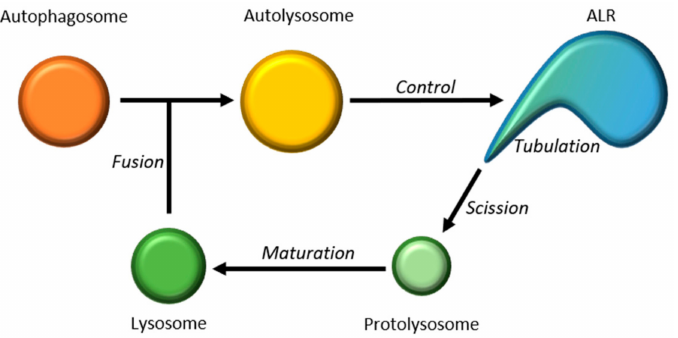
Figure 2. Autophagic lysosome reformation (ARL). Schematic illustration of the principal steps involved in the autophagic lysosome reformation. Initially, the tubular structures emerge from autolysosomes (yellow) and small vesicles bud off these tubules (protolysosome, in light green) to mature into functional lysosomes (dark green). The renewed pool of lysosomes can re-enter the flux fusing with the autophagosomes (orange) and generating